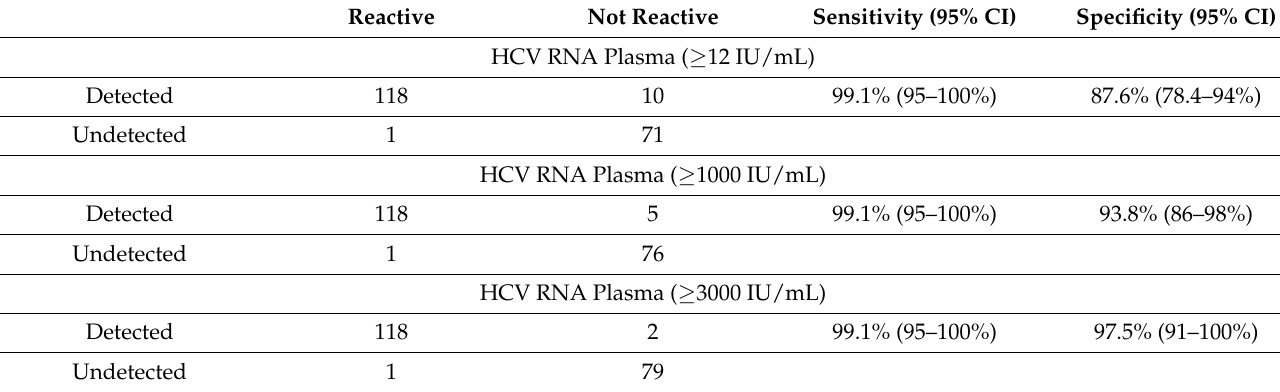
Table 3. Sensitivity and specificity of HCV core antigen plasma ( ≥ 10 fmol/L) compared with different HCV RNA